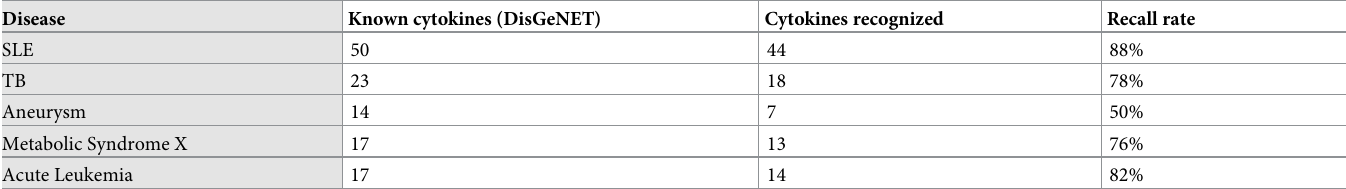
Table 6. The recall rate (column #4) of these cytokines being recognized by the predicted subnetworks formed by high-confidence associations ranges from 50% to 88%. Disease